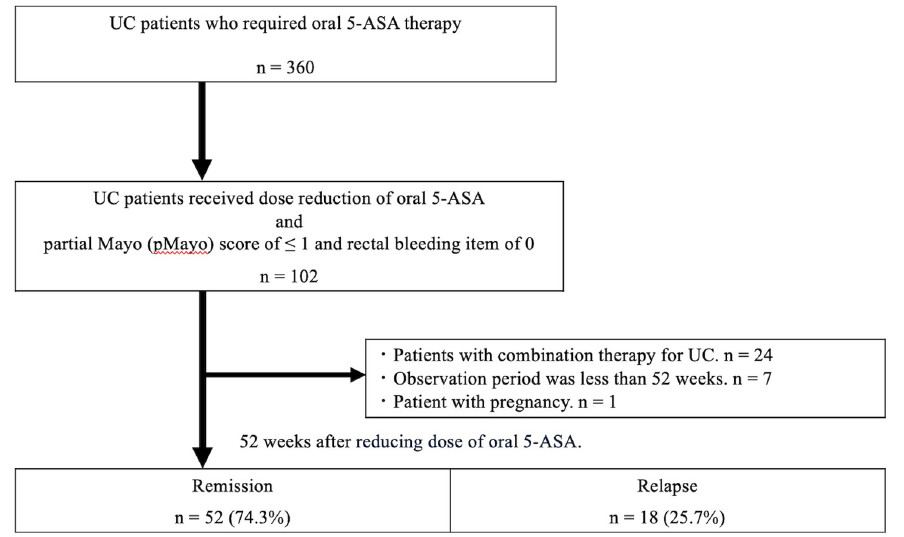
Fig 1. Flow diagram of this